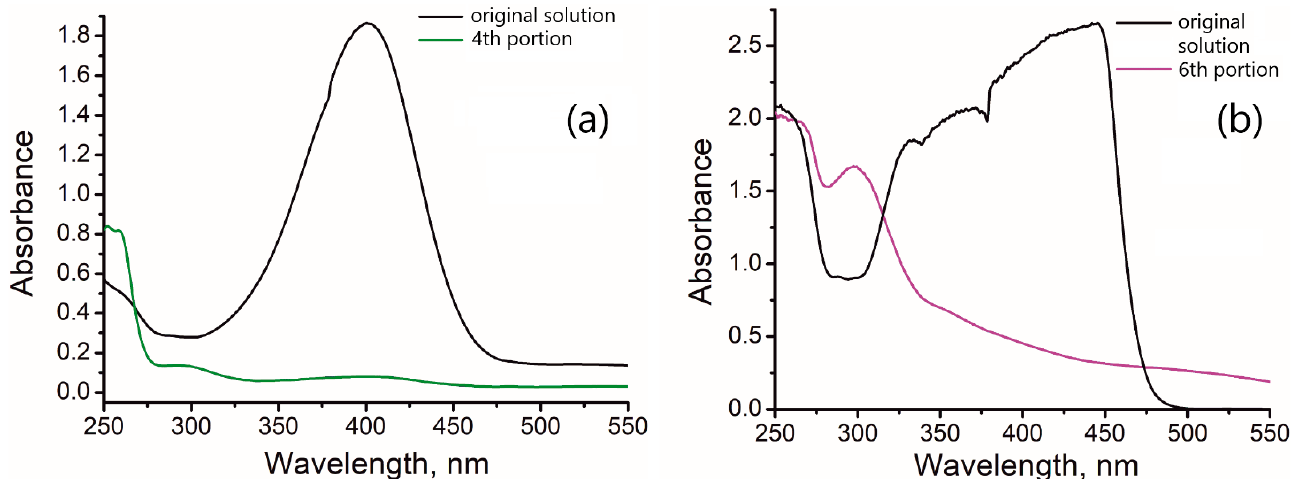
Figure 6. The UV – Vis spectra of original mixtures 1 ( a ) and 2 ( b ) and corresponding reduction prod- ucts.